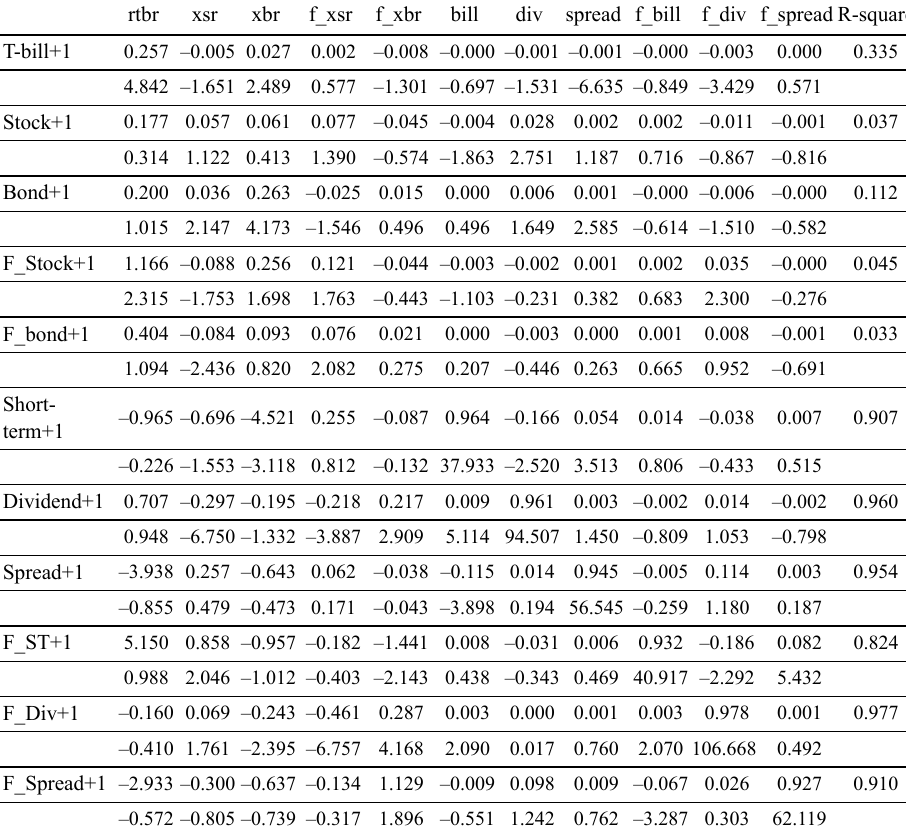
Table 8. An investor from SA who can invest in domestic assets and assets from the UK,